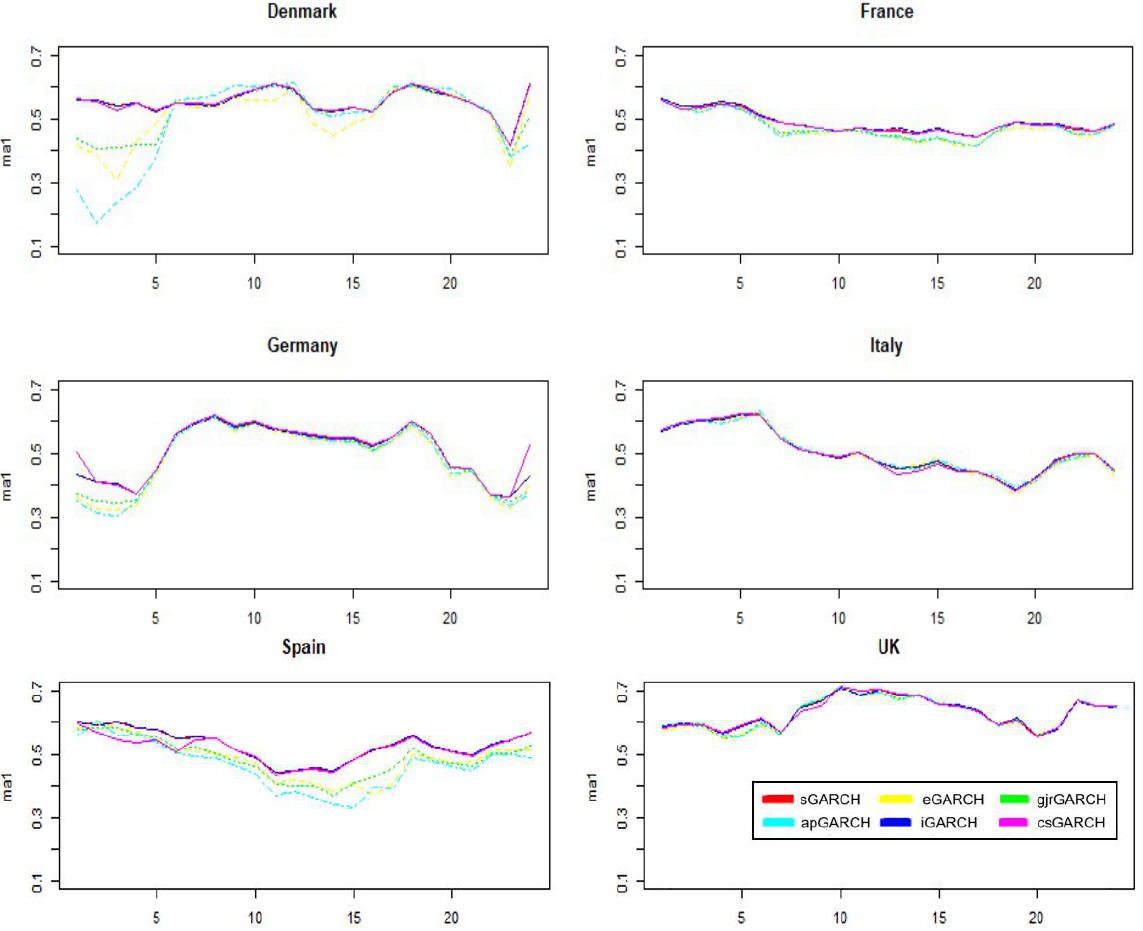
Figure 9. The changes in the parameter estimate according to the different models for each country.